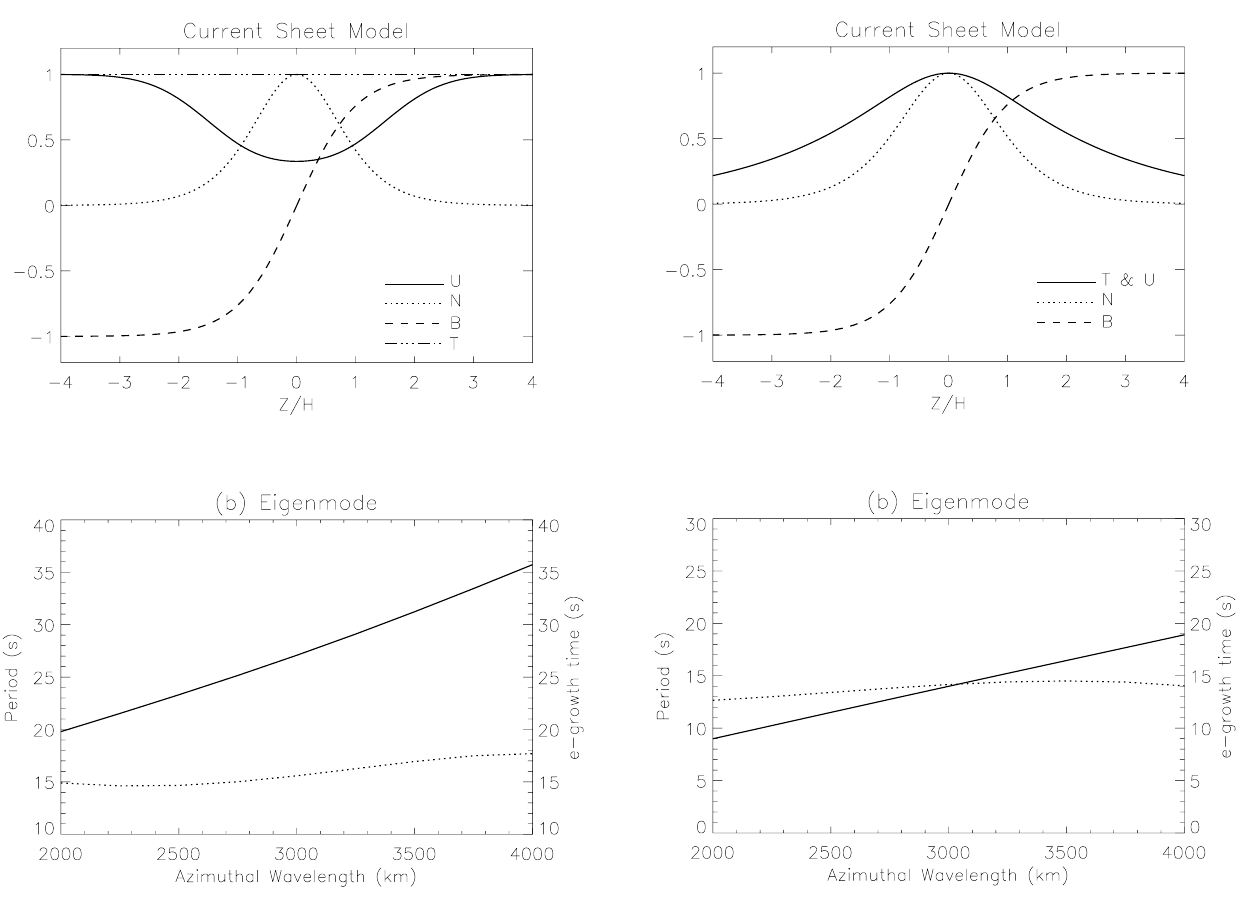
Fig. 2. Numerical solution of the unstable eigenmode for the case given in Eq. (37) and parameters given the subsequent text. Plot (a) shows the variation of the background quantities of the model current sheet. Plot (b) gives the real (solid) and imaginary (dotted) parts of the eigenvalue as a function of azimuthal wave- length.